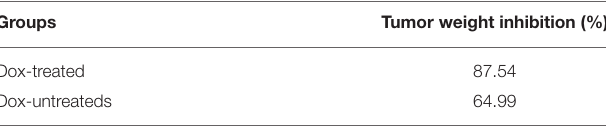
TABLE 1 | Tumor weight inhibitory rates after Photofrin-mediated PDT *